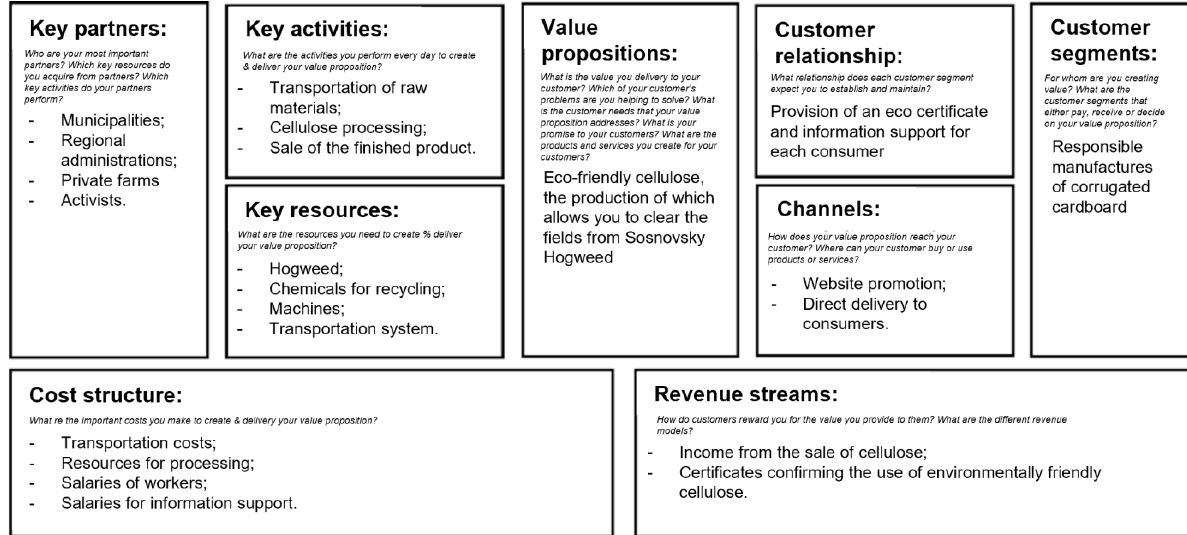
Figure 4. Business Model Canvas for all types of business models.